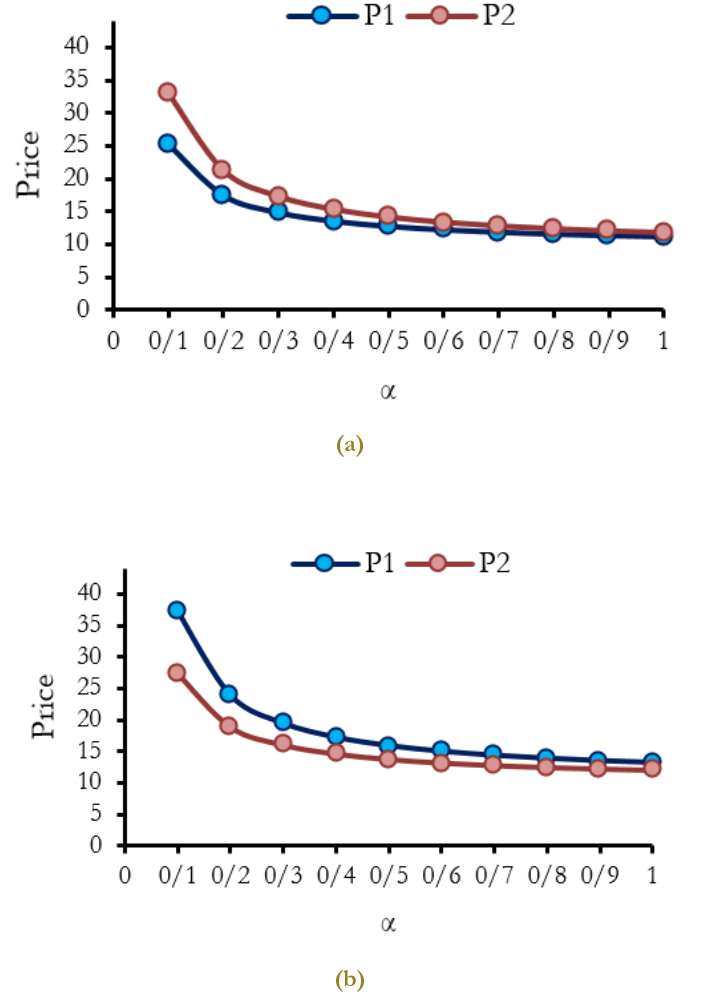
Fig. 5. The impact of α on the prices of service provided by the dental centers: (a). λ = 0 ; (b). λ =